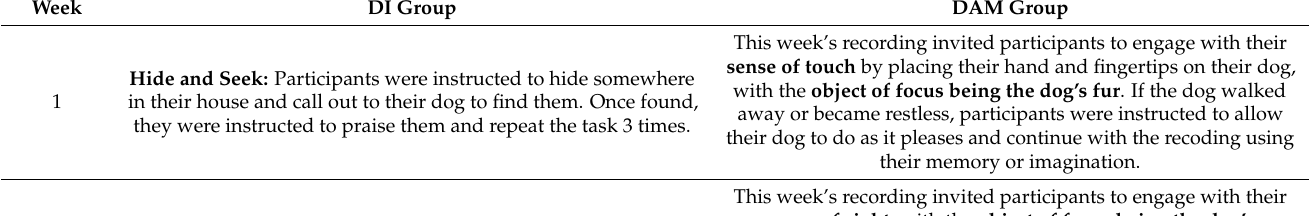
Table 2. Six week session activity description for Dog Interactions (DI) and Dog Assisted Mindfulness (DAM) groups. Week DI Group DAM Group Hide and Seek: Participants were instructed to hide somewhere 1 in their house and call out to their dog to find them. Once found, they were instructed to praise them and repeat the task 3